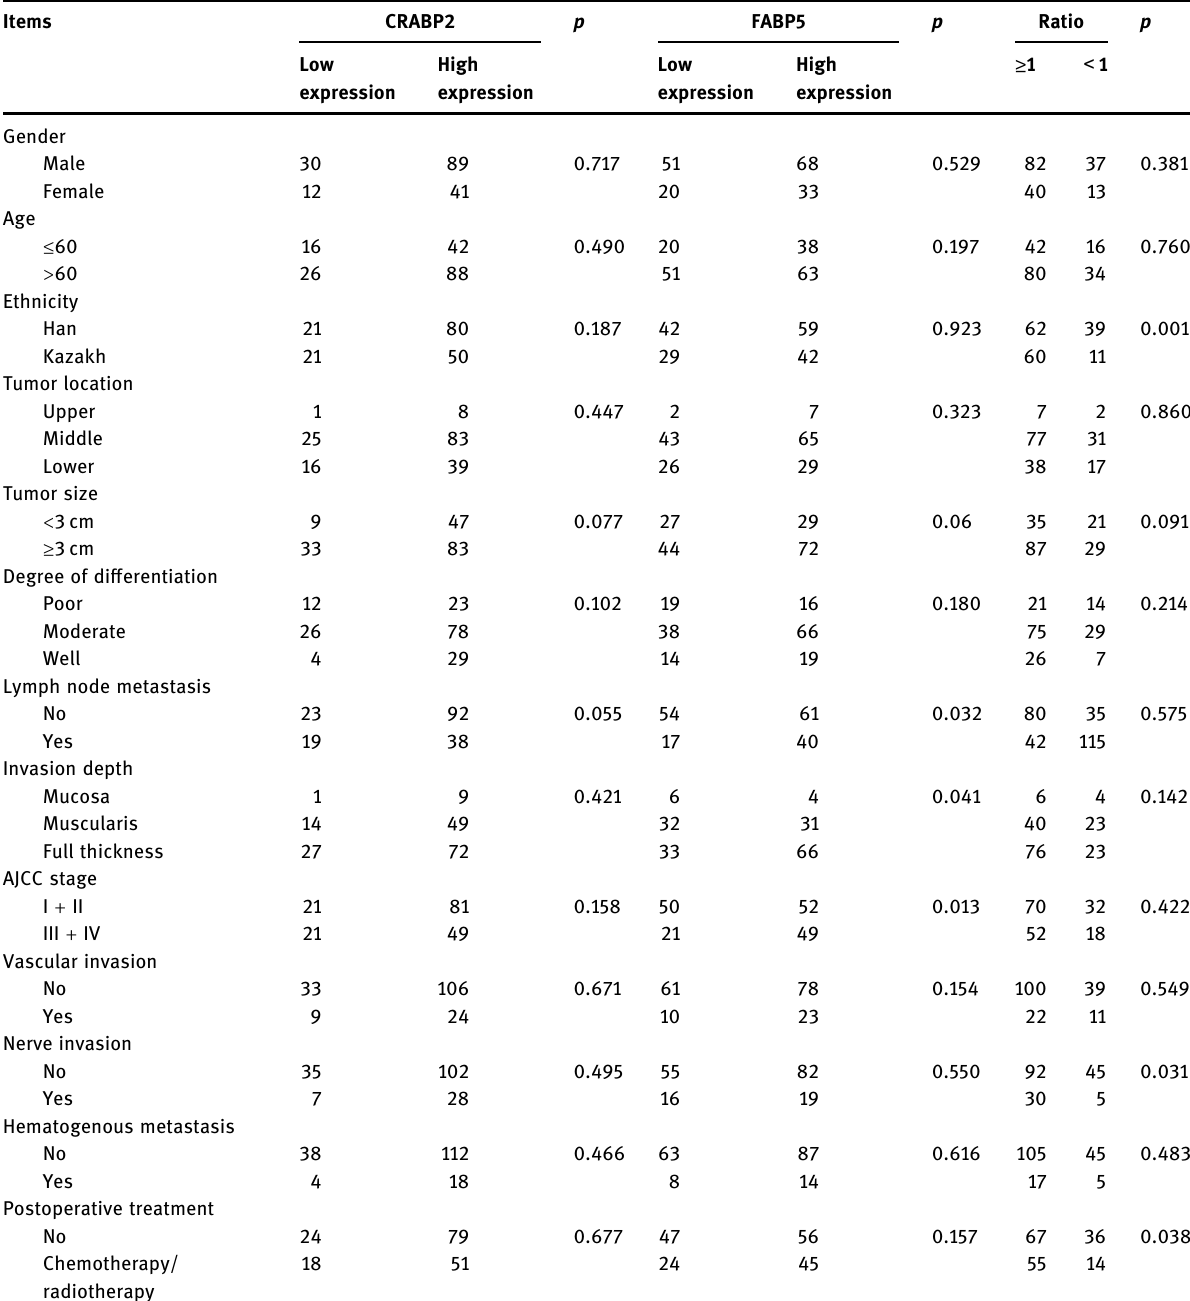
Table 3: CRABP2, FABP5, CRABP2/FABP5 levels in esophageal squamous cell carcinoma and their relationship with clinicopathological